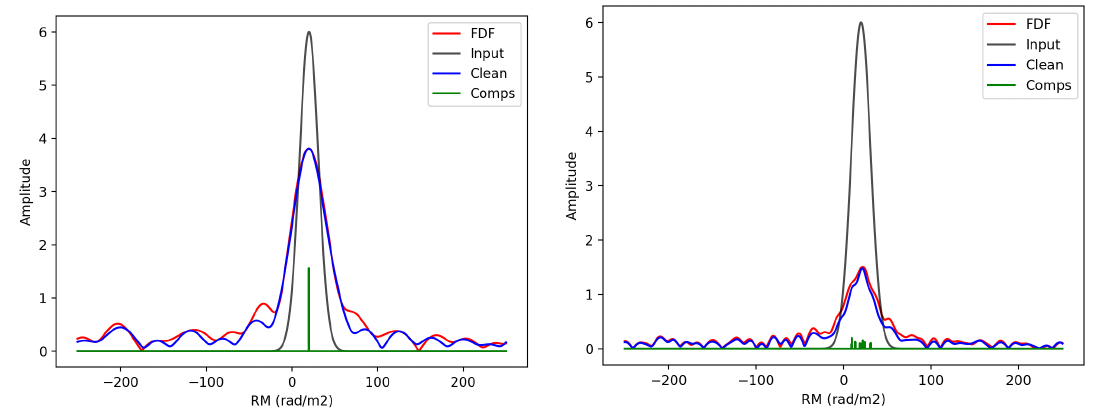
Figure 3. Examples of the results of the RM CLEAN. The left and right figures show the results for the model g 1 a using the frequency band case IV and case V,